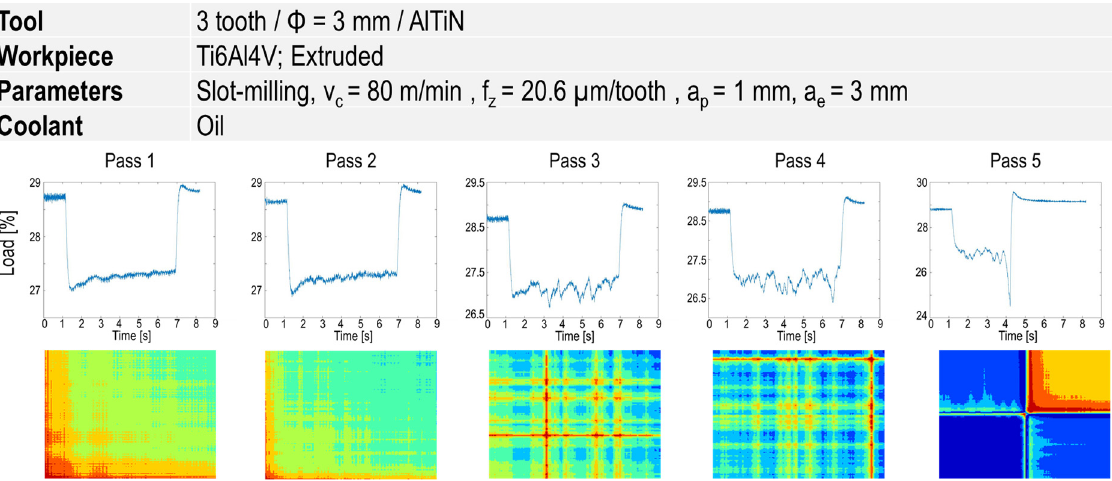
Figure 9. GASF images at five different milling passes with a new tool and at constant process pa- rameters.